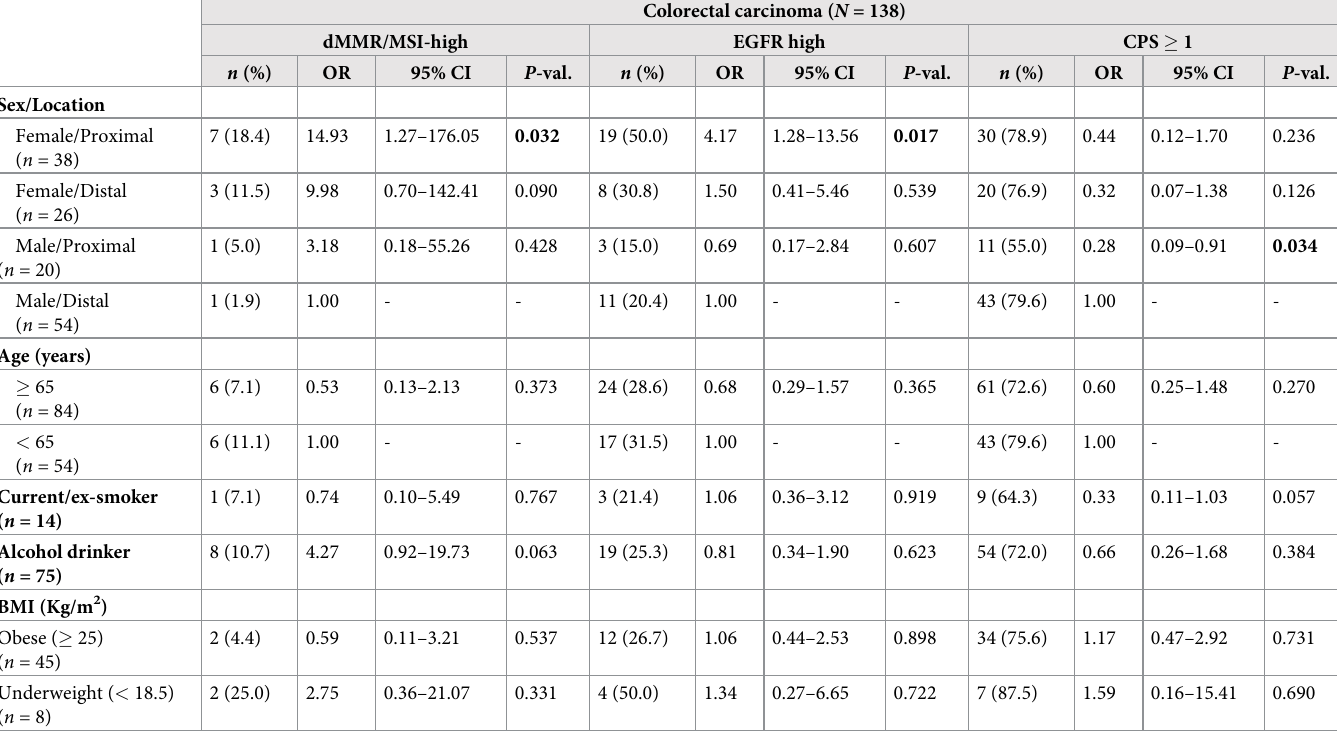
Table 5. Multivariate logistic regression analysis on factors associated with dMMR/MSI, EGFR, and PD-L1 CPS in 138 Patients with